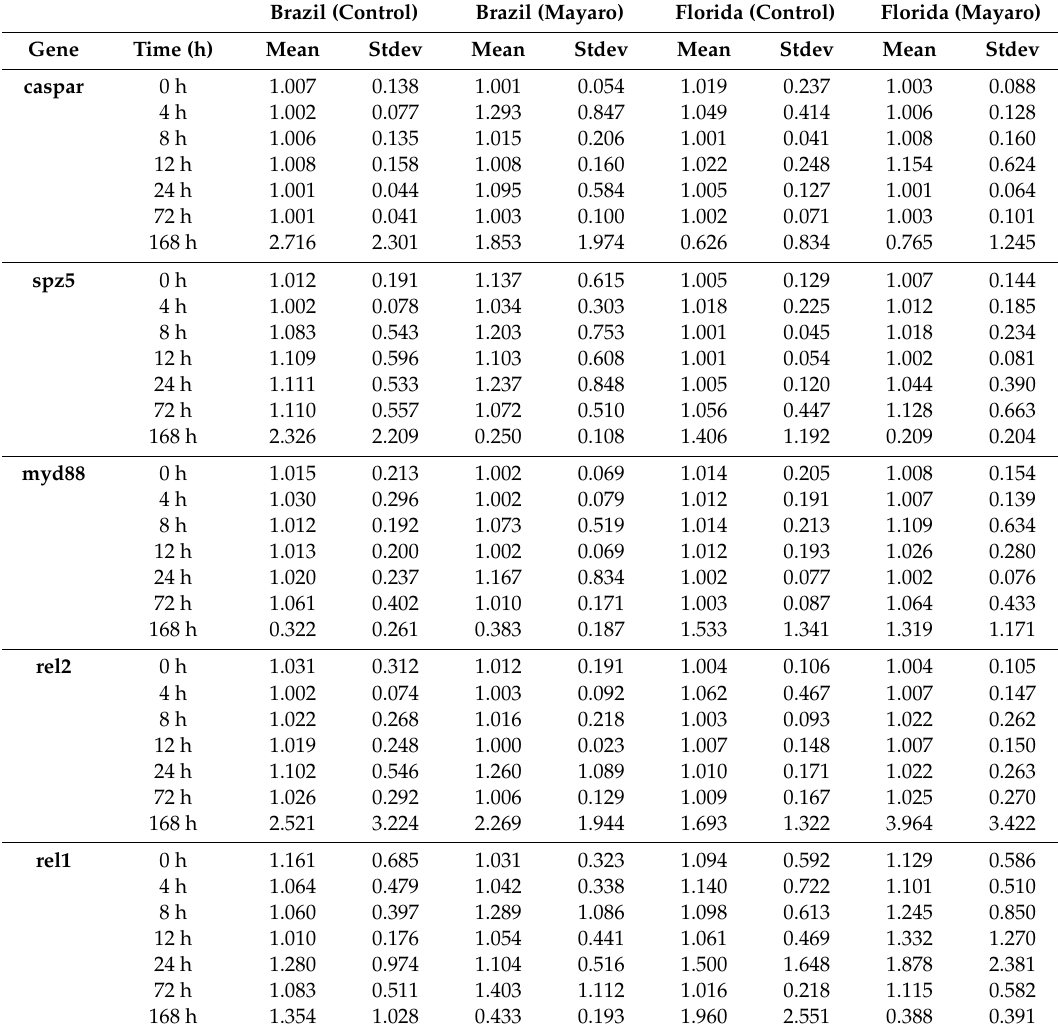
Table 5. Gene expression of antiviral immune related genes following ingestion of Mayaro virus infectious blood in Aedes